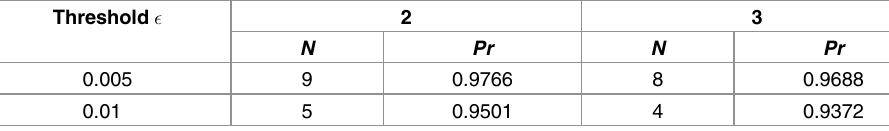
Table 15. Industry-specific P ( s ) : Concentration measurefor ~ p ð i Þ